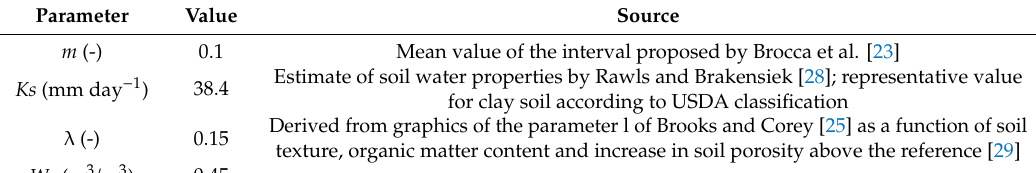
Table 1. Main soil and plant parameters used in the soil water balance and to calculate plant stress. Parameter Value